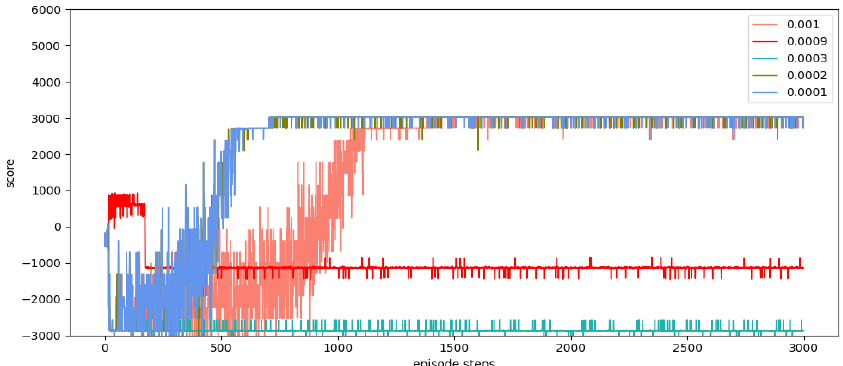
Figure 6. Training result of TD3 algorithm model in environment 2.